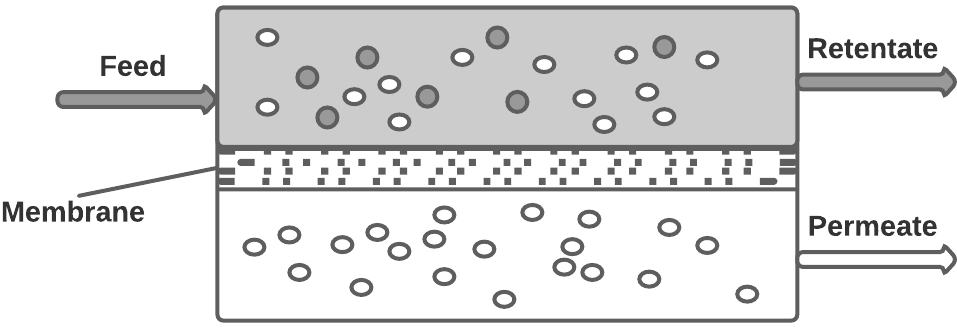
Figure 4. Membrane system